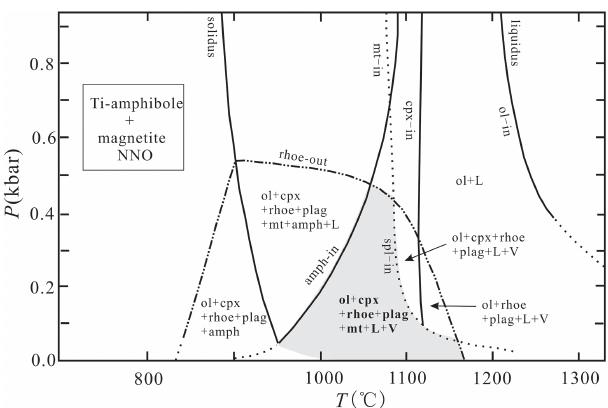
Figure 10. Liquidus–solidus relationships of Ti-rich calcium am- phibole and rhönite in alkali basalt up to 1kbar at NNO oxy- gen buffer conditions after Kunzmann (1989); the stability field of Changle rhönite is shaded in light